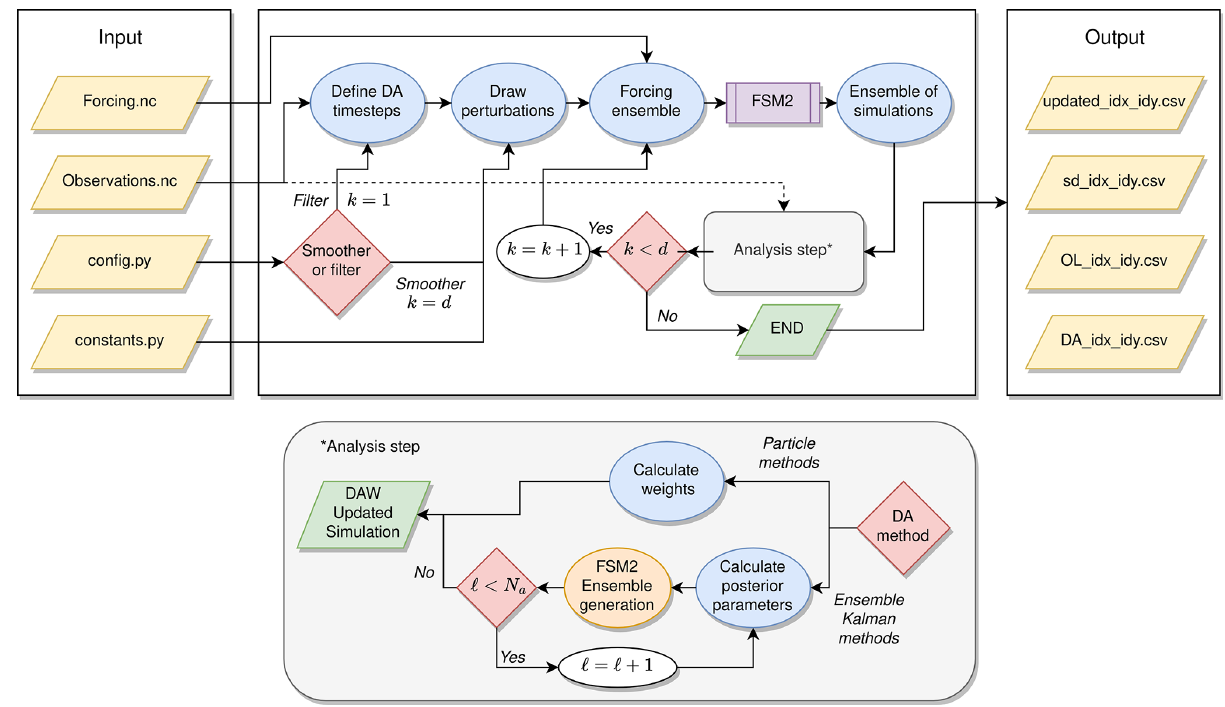
Figure 1. MuSA internal workflow. k , d , (cid:96) , N a , DAW, idx, and idy refer to the timing of the analysis step, number of observation times, current assimilation cycle number, total number of assimilation cycles, data assimilation window, longitude cell index, and latitude cell index,